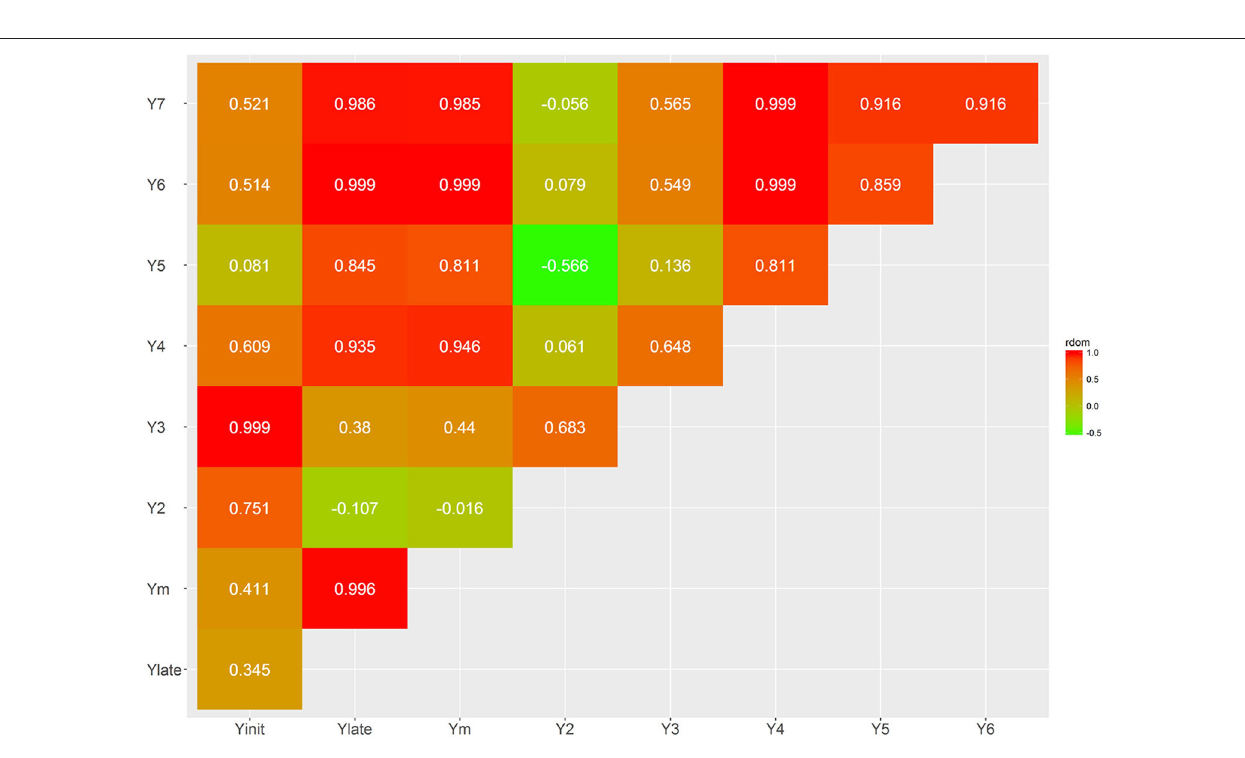
Frontiers in Plant Science |